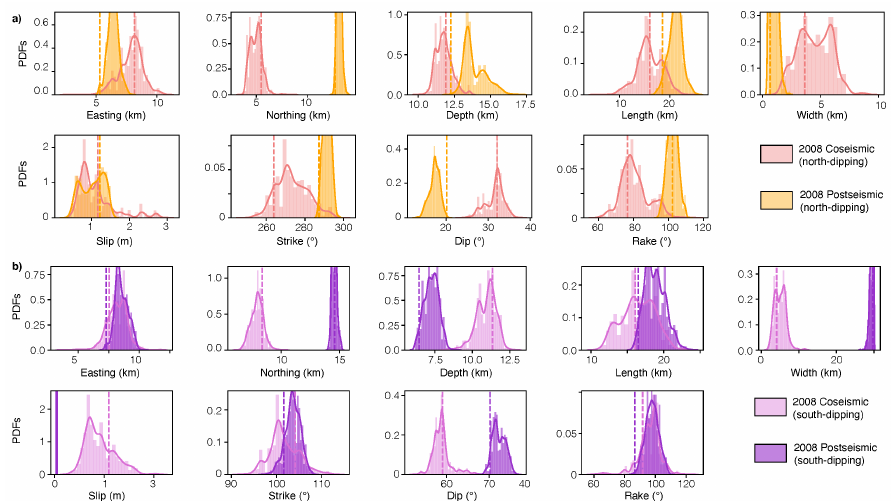
Figure 6. ( a ) Summary of the posterior PDFs for the optimisation of one north-dipping rectangular fault in agreement with the co-seismic (coral red) and post-seismic (orange) surface displacements of the 2008 earthquake. Dashed vertical lines are best-fitting models. ( b ) Same as ( a ), but for the optimisation of one south-dipping rectangular fault in agreement with the co-seismic (coral red) and post-seismic (orange) surface displacements of the 2008 earthquake.